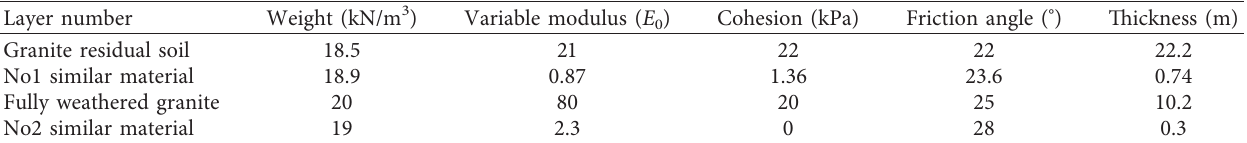
Table 3: Physical-mechanical parameters of prototype and model material.